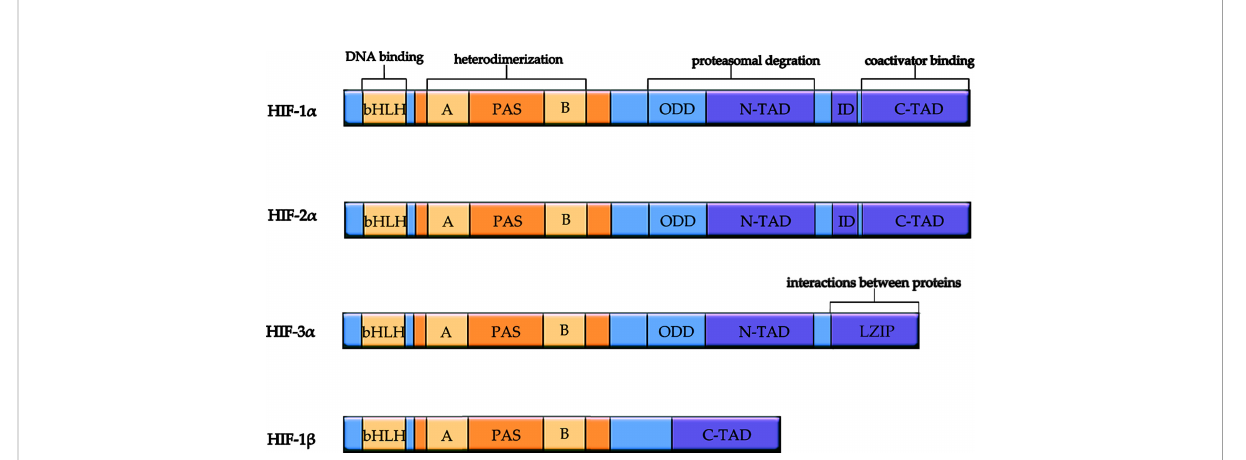
FIGURE 1 Schematic diagram of structure and function of HIF subunits. All HIF isoforms have a bHLH motif and two PAS domains responsible for heterodimerization. HIF-3 a replaces C-terminal trans-activation domain with C-terminal Leucine zipper (LZIP) domain responsible for interactions between proteins. HIF-1 b does not contain ODD domain for proteasomal degradation, N-TAD, and ID. bHLH, basic helix-loop-helix domain; PAS, Per/ARNT/Sim domain; ODD, oxygen-dependent degradation domain; ID, inhibitory domain. N-TAD, N-terminal transactivation domain; C-TAD, C-terminal transactivation